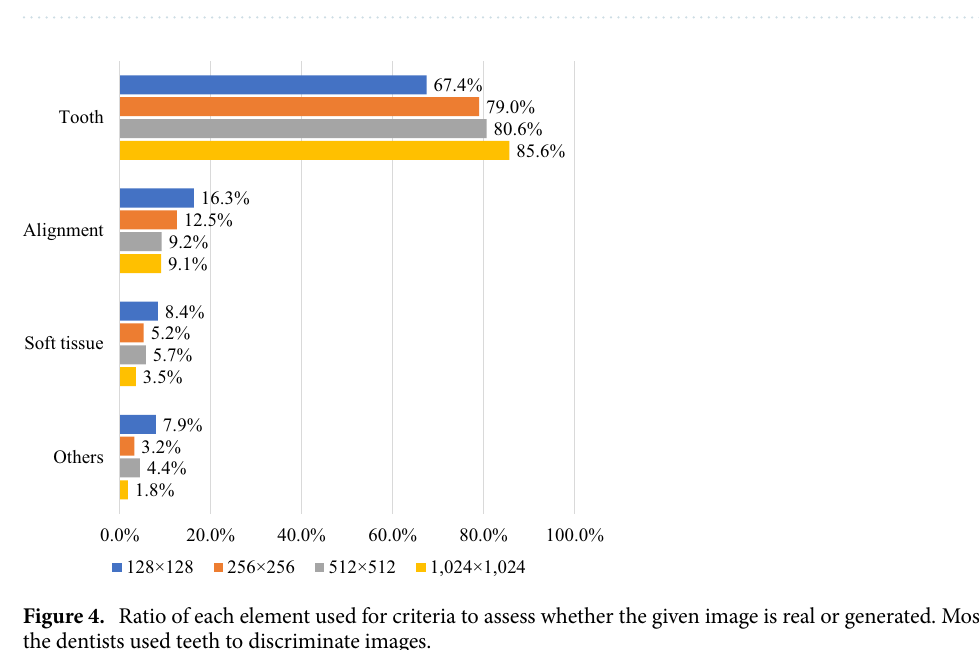
Figure 3. Boxplot of d prime for each resolution. The black dots indicate the raw data of the 12 dentists. The d prime of 1024 × 1024 was significantly higher (TukeyHSD test).